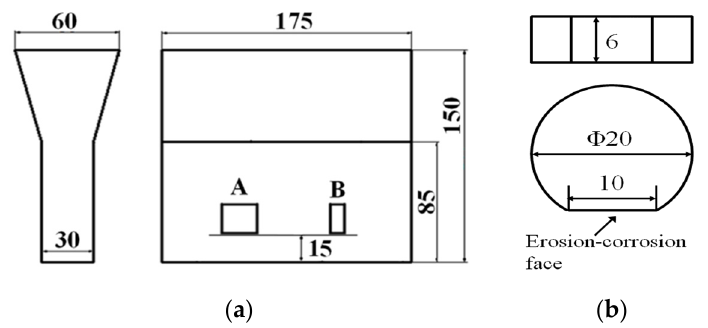
Figure 1. Geometric sizes of Y block ( a ) and erosion–corrosion sample ( b ) (in mm).